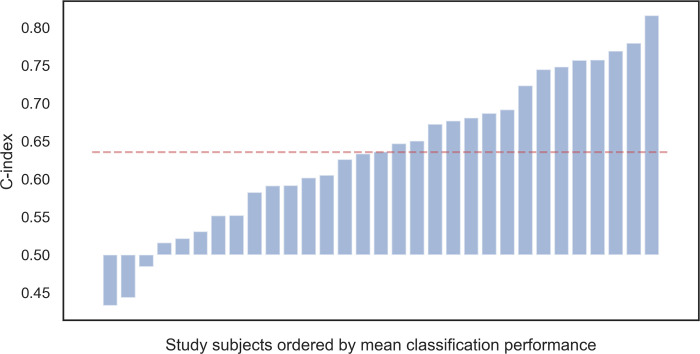
The average subject performance.The average concordance performance (c-index) of the ordinal classification for each subject (ordered by average c-index) compared to the random prediction level (0.5). Red (dashed) line shows the average performance of the final model (0.64).